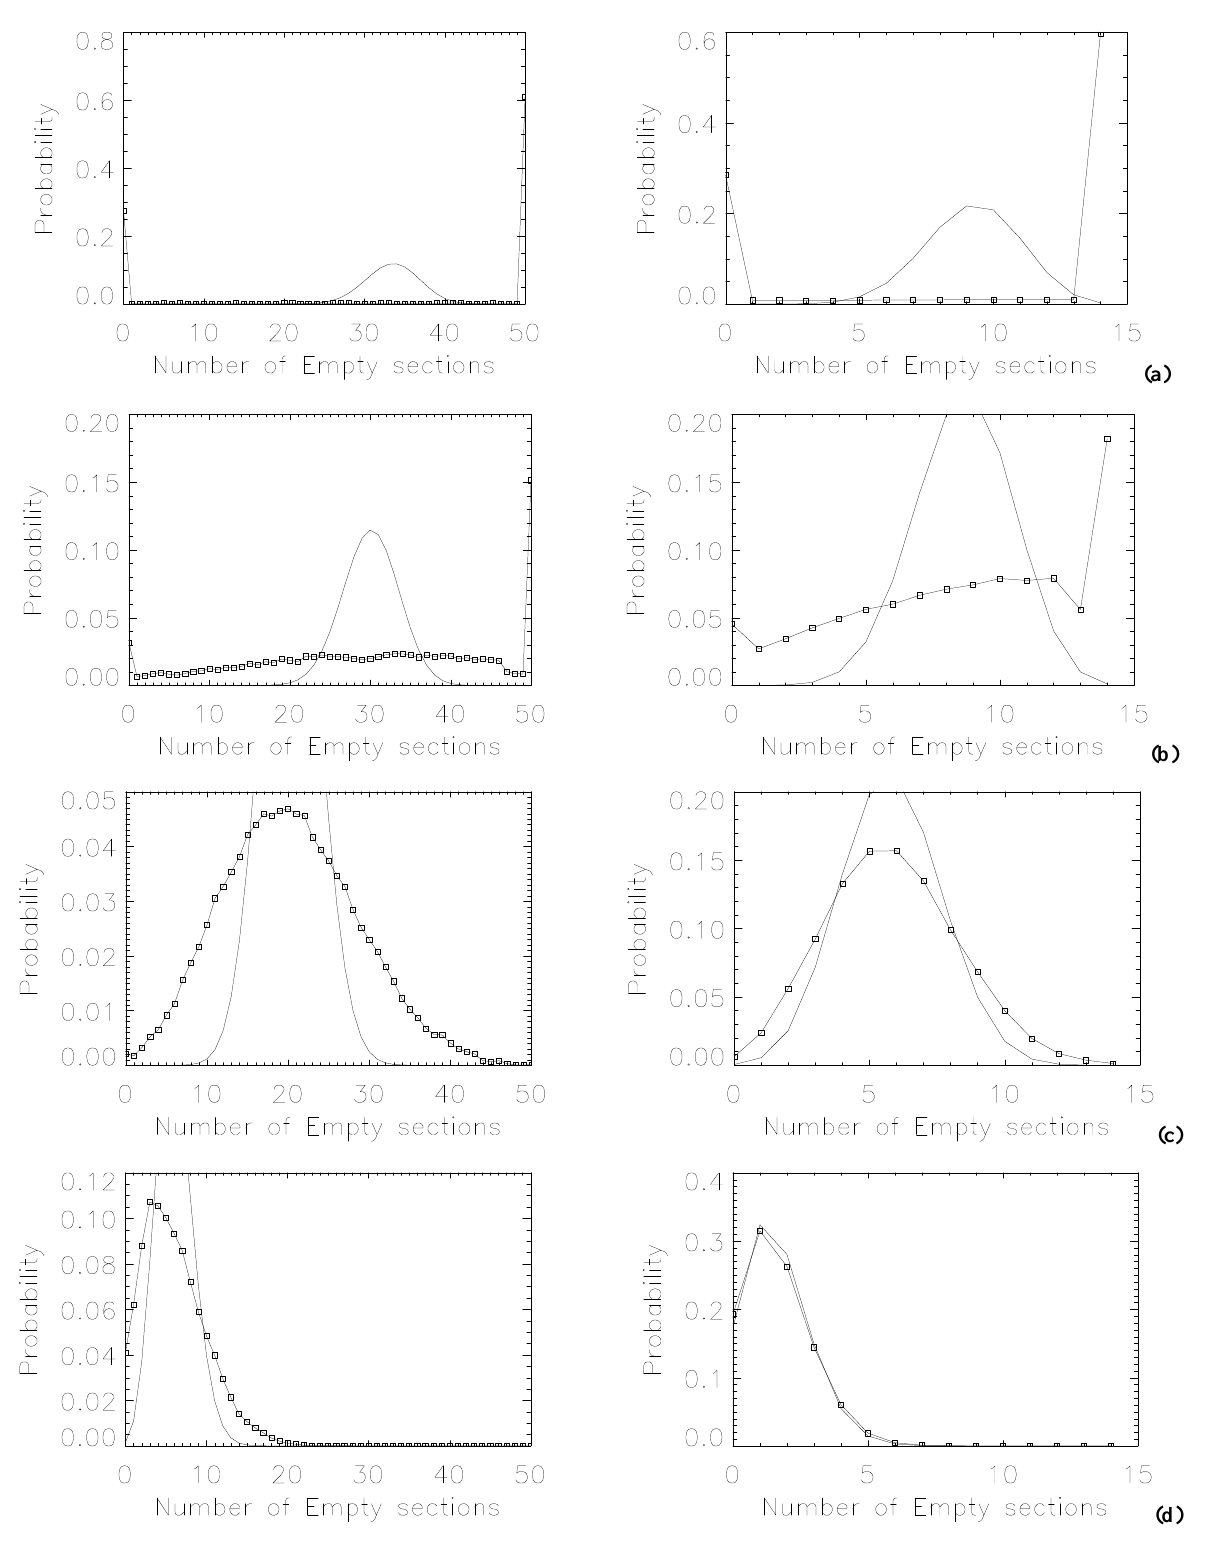
Fig. 1. The probability mass function (squares) for the number of uncontaminated 1-km sections (left-hand panels) and 3.5 sections (right- hand panels) in a 50-km interval for a cloud fraction of 33% for a mean hole length of (a) 540km, (b) 36.5km, (c) 3.5km and (d) 1.0km. Also shown is the binomial distribution that would apply if adjacent sections were assumed